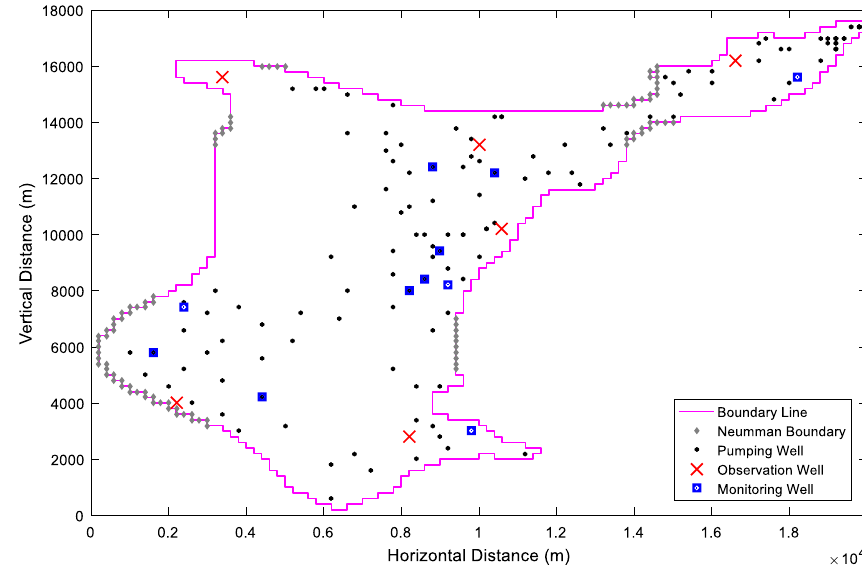
Fig. 9 Neumann boundary, pumping wells, piezometers (observation wells) and moni- toring wells